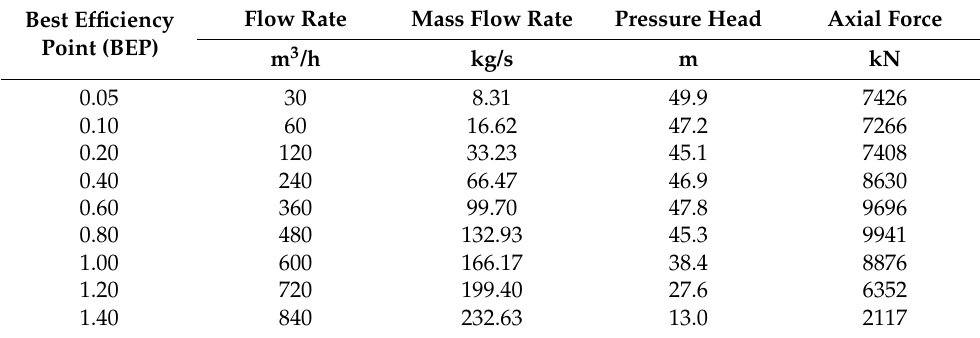
Table 3. Calculation of axial and radial forces acting on the rotor of the developed pump ACNA